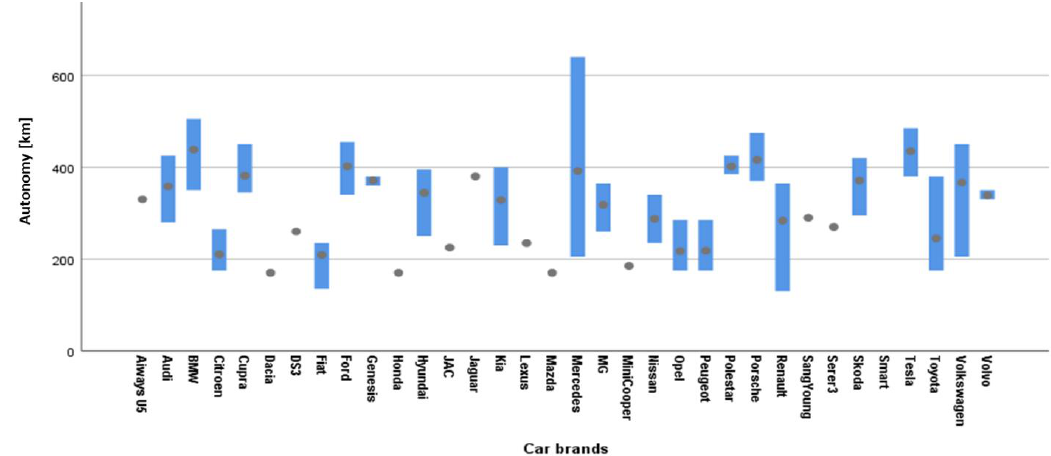
Energies 2023 , 16 , x FOR PEER REVIEW